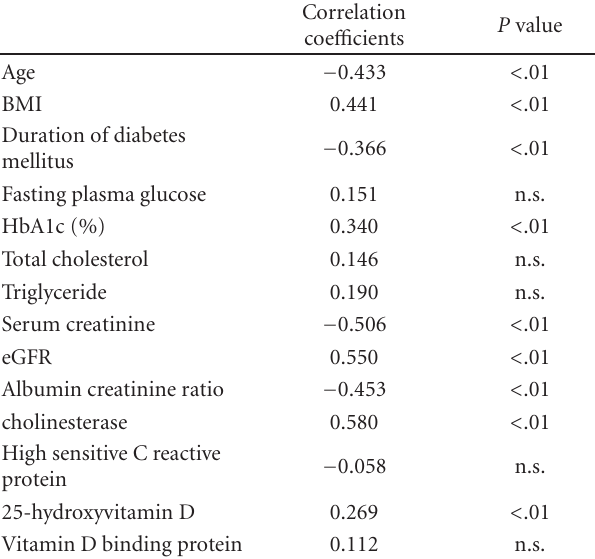
Table 2: Correlation of hemoglobin concentration with clinical covariates. Spearman’s rank test was performed. P < . 05 was considered statistically significant. “n.s.” denotes “not significant.” Statistical analyses were performed using SPSS 18.0 statistical software.